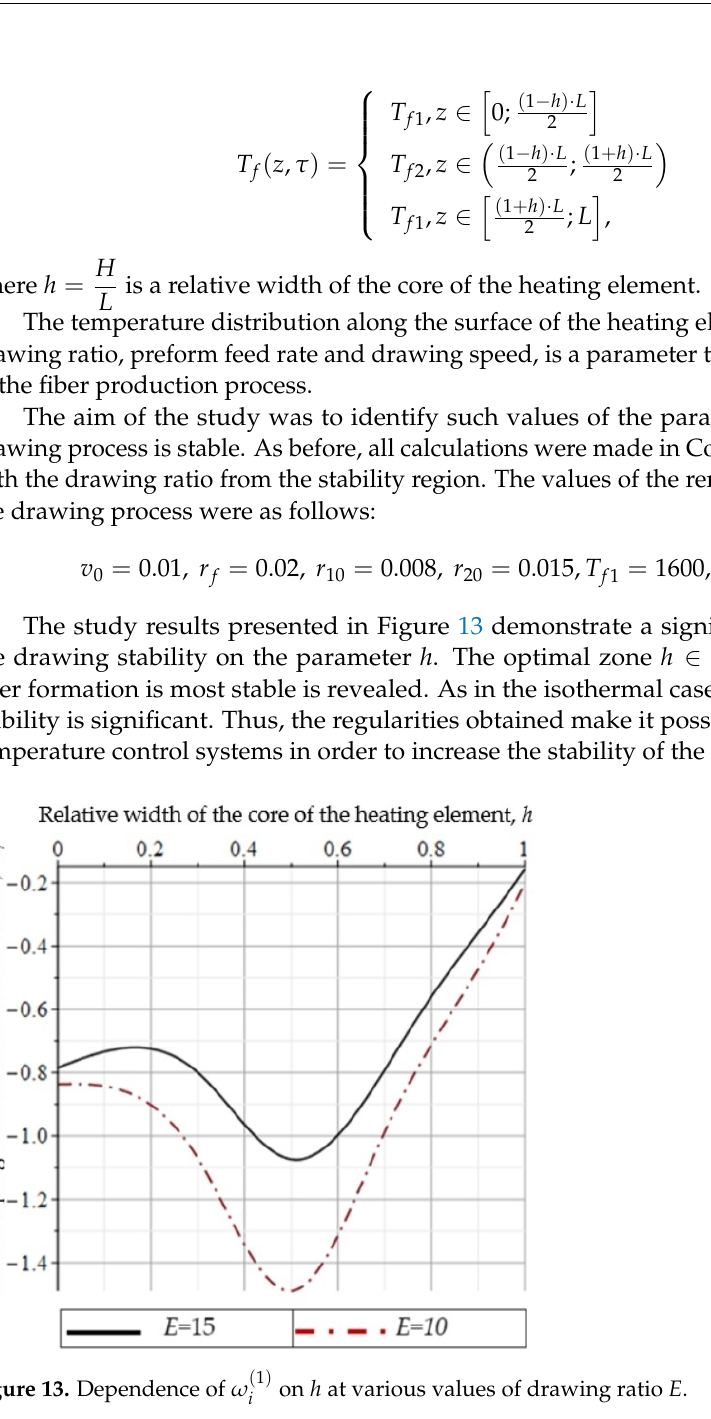
Figure 13. Dependence of ω (1)